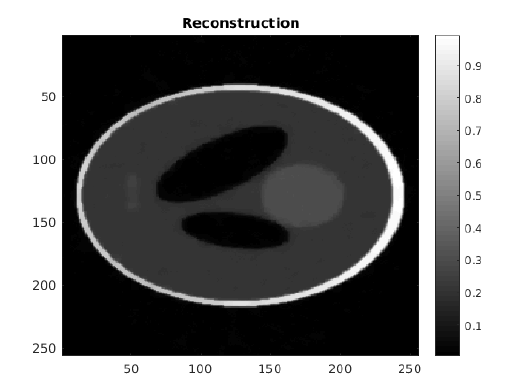
Figure 4. Reconstruction by VBA.